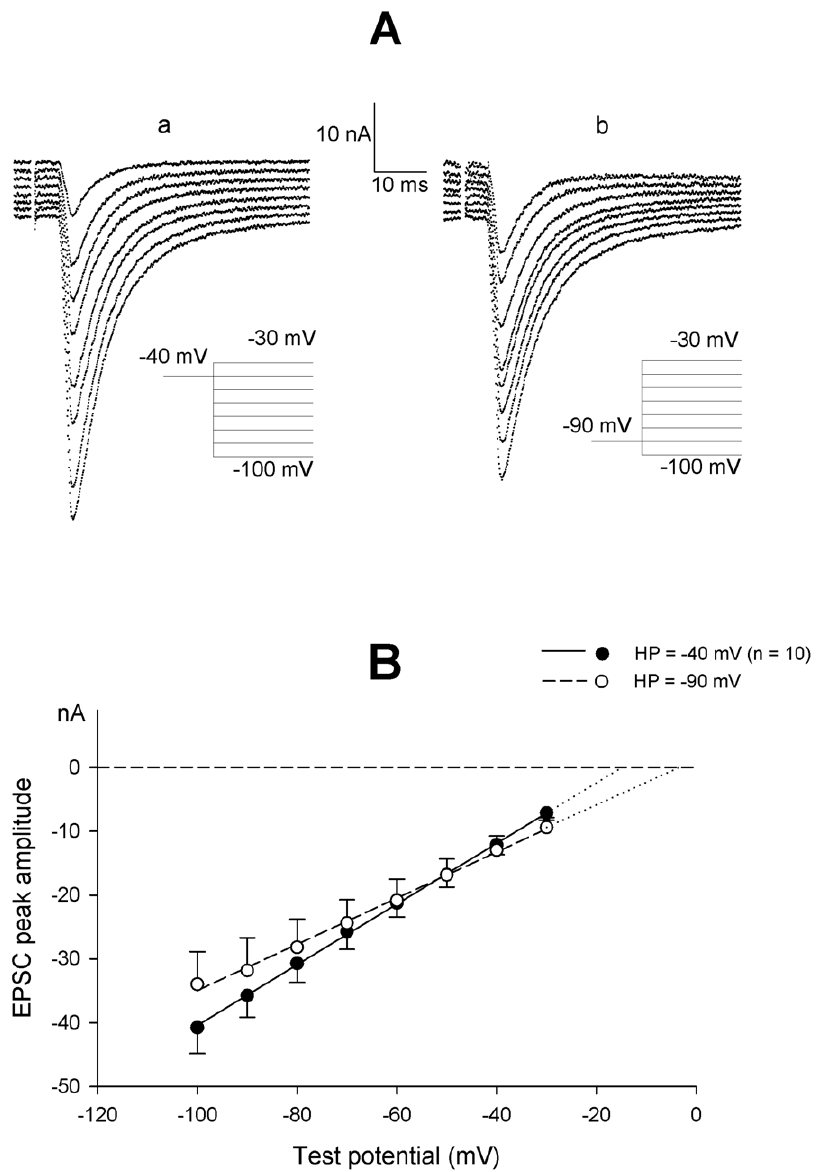
Figure 1. Effect of holding potential on EPSC properties. ( A ). Representative tracings showing the effect of voltage on the EPSC I–V relationship in a neuron maintained at 2 40 (a) or 2 90 mV (b) holding potential. EPSCs were evoked in either case at test command potentials over the same 2 30/ 2 100 mV membrane potential range in 10 mV steps. Peak EPSC amplitude of the tracings was fitted by the Goldman current equation over the whole voltage range tested, providing an estimate of E ACh as derived from the P K /P Na ratio ( 2 14.5 mV for VH-40 and + 3.1 mV for VH-90). ( B ). Mean I–V relationship for peak EPSC amplitude. Data from 10 neurons held at 2 40 (filled circles) and subsequently at 2 90 mV (open circles) holding potential. Analysis indicates a shift of the mean P K /P Na ratio from 1.40 6 0.13 (VH-40) to 0.92 6 0.10 (VH-90). doi:10.1371/journal.pone.0017318.g001 current tracings as in Figure 1B by computing the ratio synaptic- command potentials, respectively, whereas in neurons held at charge/ t EPSC and plotted versus the test potential. These new null point estimates (np -40mV = 2 17.6 mV; np -90mV = + 0.4 mV) were (n =10). Since the decay time constant reflects the mean open time of the nicotinic channel, its modifications affect the overall very similar to those extracted from the EPSC peak amplitudes in synaptic charge. In fact, while the peak synaptic current, given Figure 1B. The voltage effect on the synaptic-charge/voltage curve the existing density of receptors, mostly depends on the magnitude proved to be fully reversible (n =4). A similar analysis is applied in of synchronous quantal emission and the driving force for the Figure 2C to a different neuron sample. permeable ion species, the total synaptic charge is also affected by Fitting of the series of I–V curves obtained in VH-40 neurons the time the nicotinic channel remains open. This offers an provided the following mean values of absolute permeability per alternative approach to estimate the driving force and E ACh . The neuron: P K = 0.984 fl/s and P Na =0.701 fl/s, suggesting a perme- current through the receptor was thus evaluated from the same ability ratio P K /P Na =1.40 6 0.13 (n= 10). The observed changes